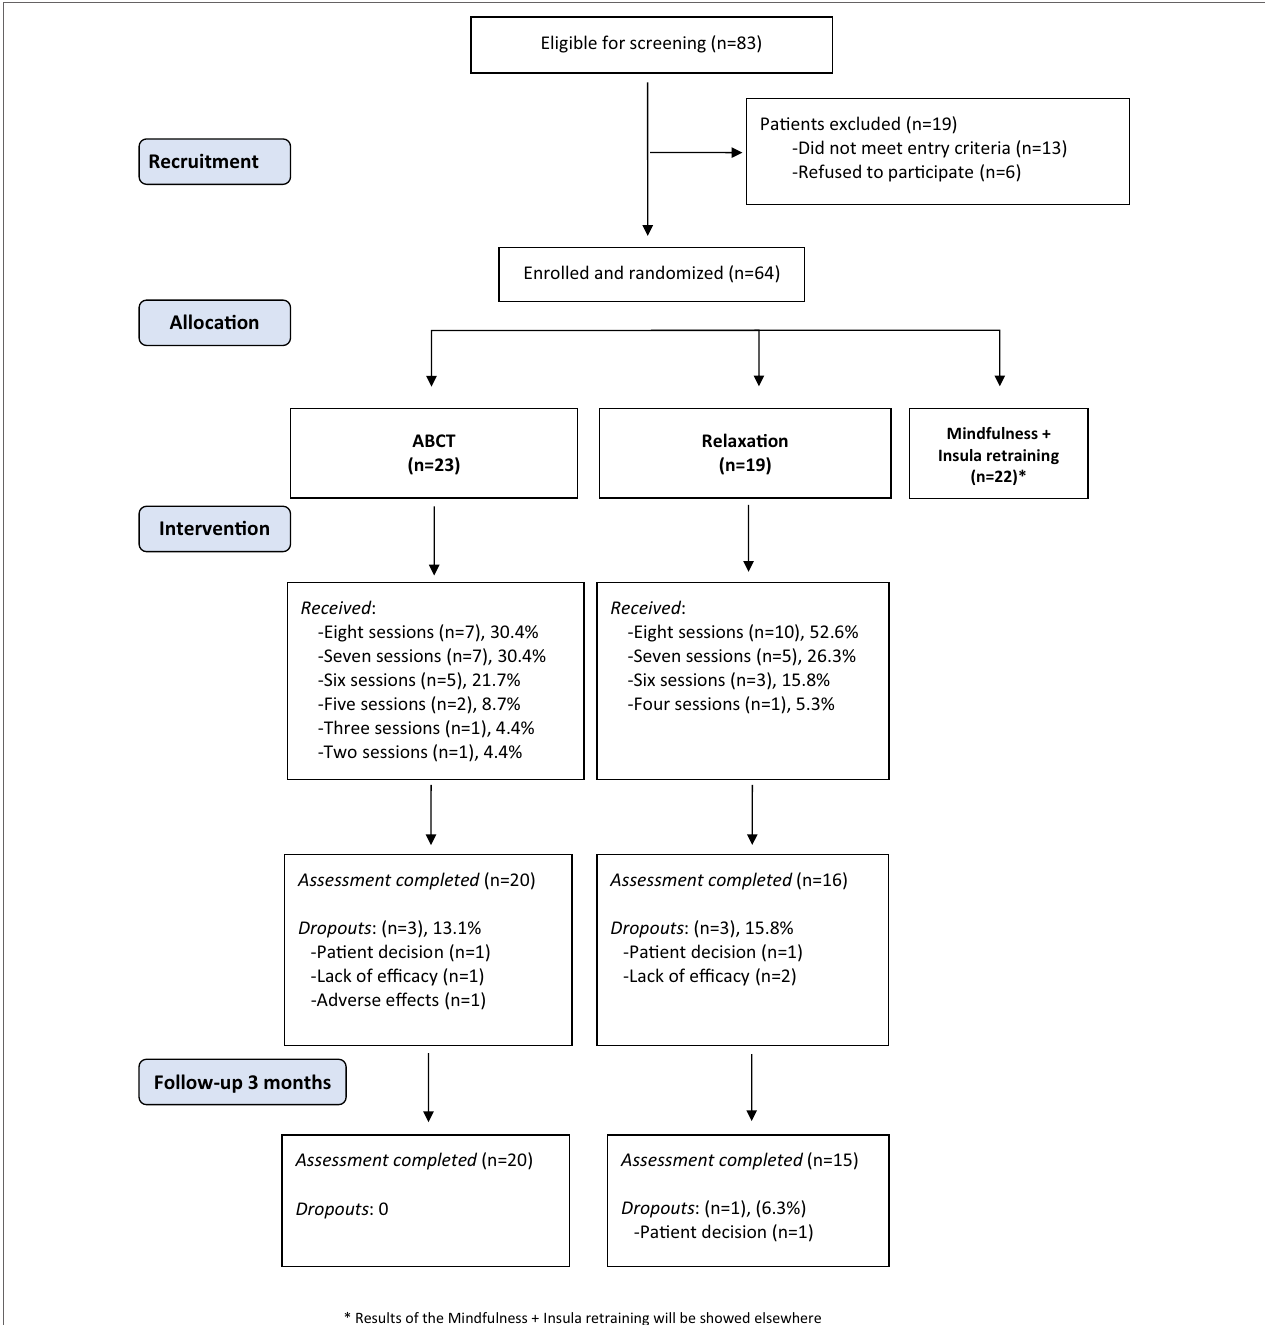
FigUre 1 | Flowchart of participants in the randomized controlled